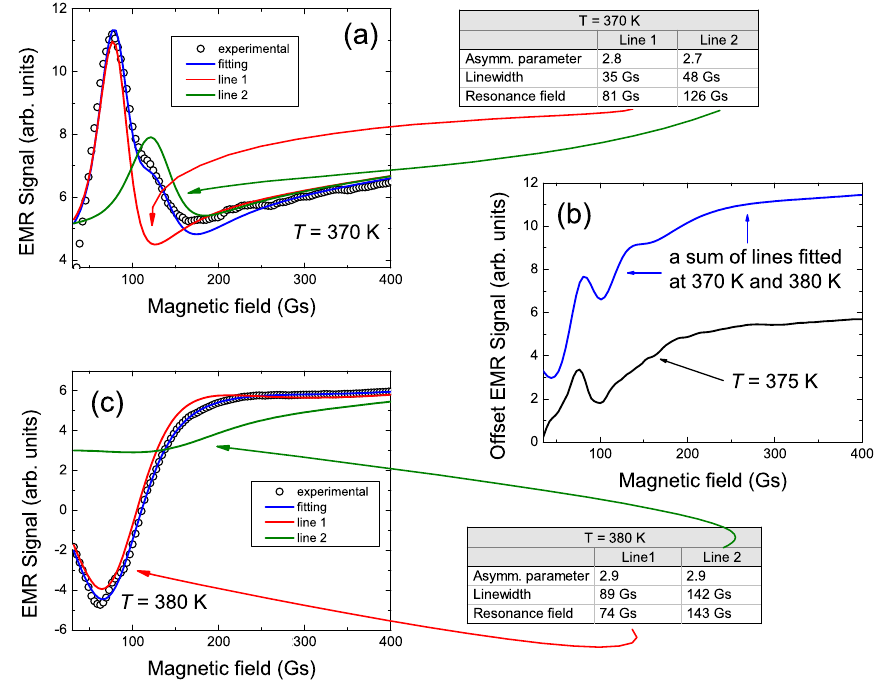
Figure 4. Representative LFMA signals for Ni 45 Co 5 Mn 35.5 In 14.5 annealed ribbon, their fitting by Dyson curves and fitting parameters at 370 K ( a ), 375 K ( b ) and 380 K ( c